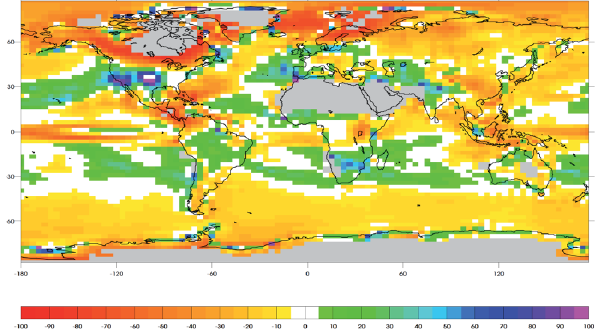
Fig. 2. Difference in annual precipitation (%) between present-day and LGM (LGMP-CTRLP) simulated by the IPSL CM4 v1 GCM. Grey areas are regions for which annual precipitation is lower than 100mm.yr − 1 .